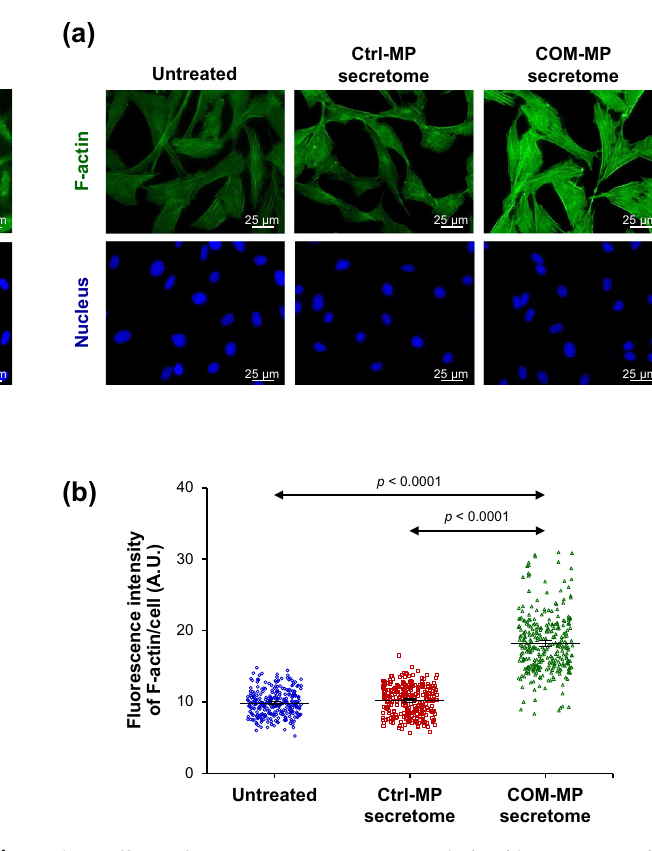
Fig. 7 Effects of COM-MP secretome on F-actin level in BHK-21 renal fi broblasts. BHK-21 cells were incubated in fresh serum-free medium without any treatment (untreated control) or in fresh serum-free medium mixed 1:1 (v/v) with Ctrl-MP secretome or COM-MP secretome for 24 h. a Immuno fl uorescence staining of F-actin using Oregon Green 488- conjugated phalloidin. Nuclei were stained in blue using Hoechst dye. b Quantitative analysis of fl uorescence intensity of F-actin was obtained from at least 100 cells in ≥ 10 random HPFs for each sample using NIS- Elements D V.4.11 (Nikon). The data were obtained from three independent experiments using different biological replicates and the bars indicate mean ± SEM (all the source data are presented in Supplementary Data 4). A.U. = arbitrary